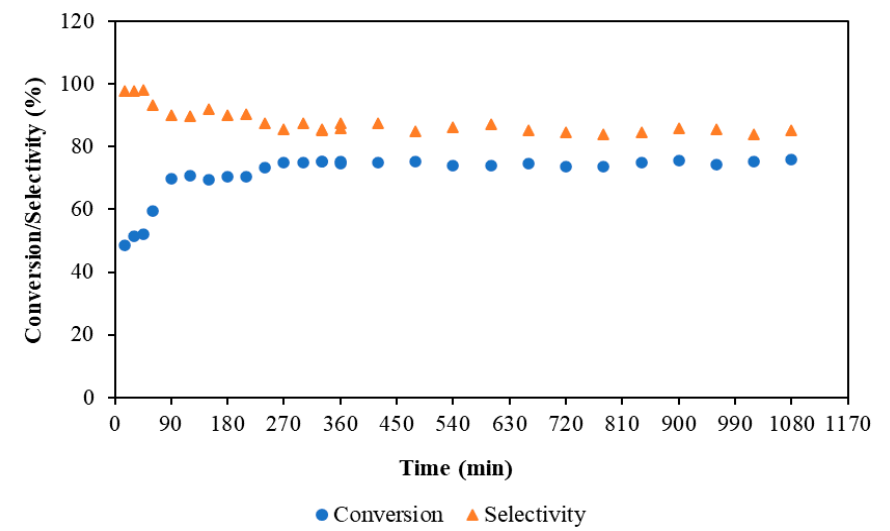
Figure 13. Time on stream study in a continuous flow stirred multiphase reactor. Epichlorohydrin 0.1 mol, n-decane 0.03 mol, toluene 150 cm 3 , guaiacol 0.1 mol, sodium hydroxide 0.2 mol, sodium chloride 0.6 mol, tetra-n-butylammonium bromide 0.14 mol, and water 150 cm 3 . Temperature 40 °C, speed of agitation of all three stirrers 60 rpm, and reaction time 18 h (1080 min).